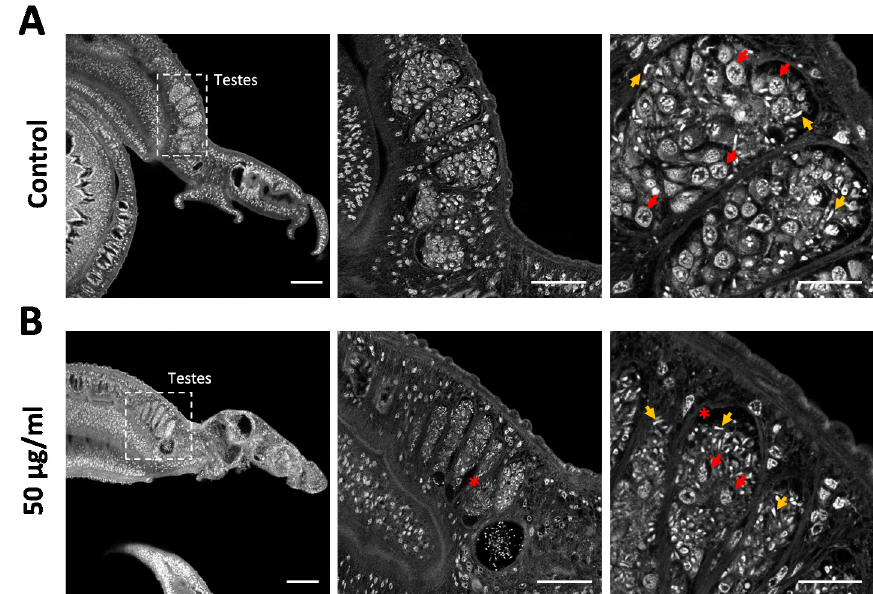
Figure 6. Rhynocoris iracundus venom reduces the number of spermatogonia in the testes of Schistosoma mansoni. Pairs of worms were treated with 50 µg/mL of venom for 72 h and males were stained with carmine red to reveal morphological details. (A) Control males feature typically pronounced testicular lobes filled with large spermatogonia (red arrows show examples) and different stages of maturing cells. Mature spermatozoa appear as small white comma-shaped cells (yellow arrows). (B) Testicular lobes in venom-treated males appear shrunken, include atypical cell-free areas (marked with *), and lack most of the spermatogonia, whereas mature spermatozoa are still present. The remaining spermatogonia show evidence of intracellular degradation. Scale bars = 100 µm (left), 50 µm (center), 20 µm (right).